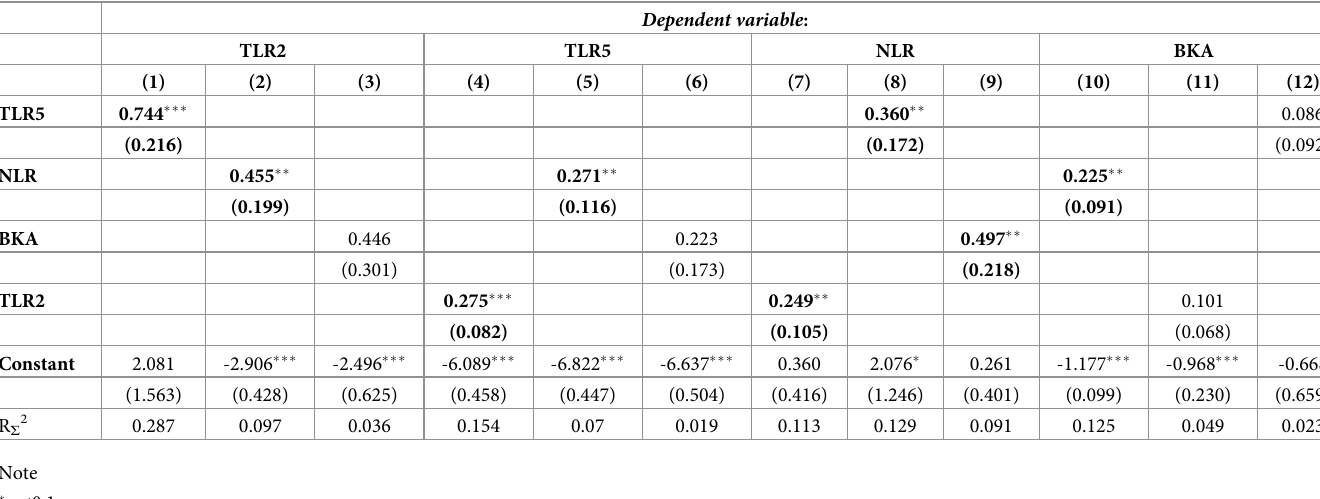
Table 2. Summary of mixed-effect models comparing innate immunity measures. Linear mixed models (see Methods) were used to find correlations between neutro- phil to lymphocyte ratio (NLR), toll-like receptors 2 and 5 (TLR2 and 5), and a plasma bacterial killing assay (BKA). All parameters were log-transformed. Species was used as a random effect. The estimates of dependent variables are displayed with standard error below in parentheses. Asterisks designate